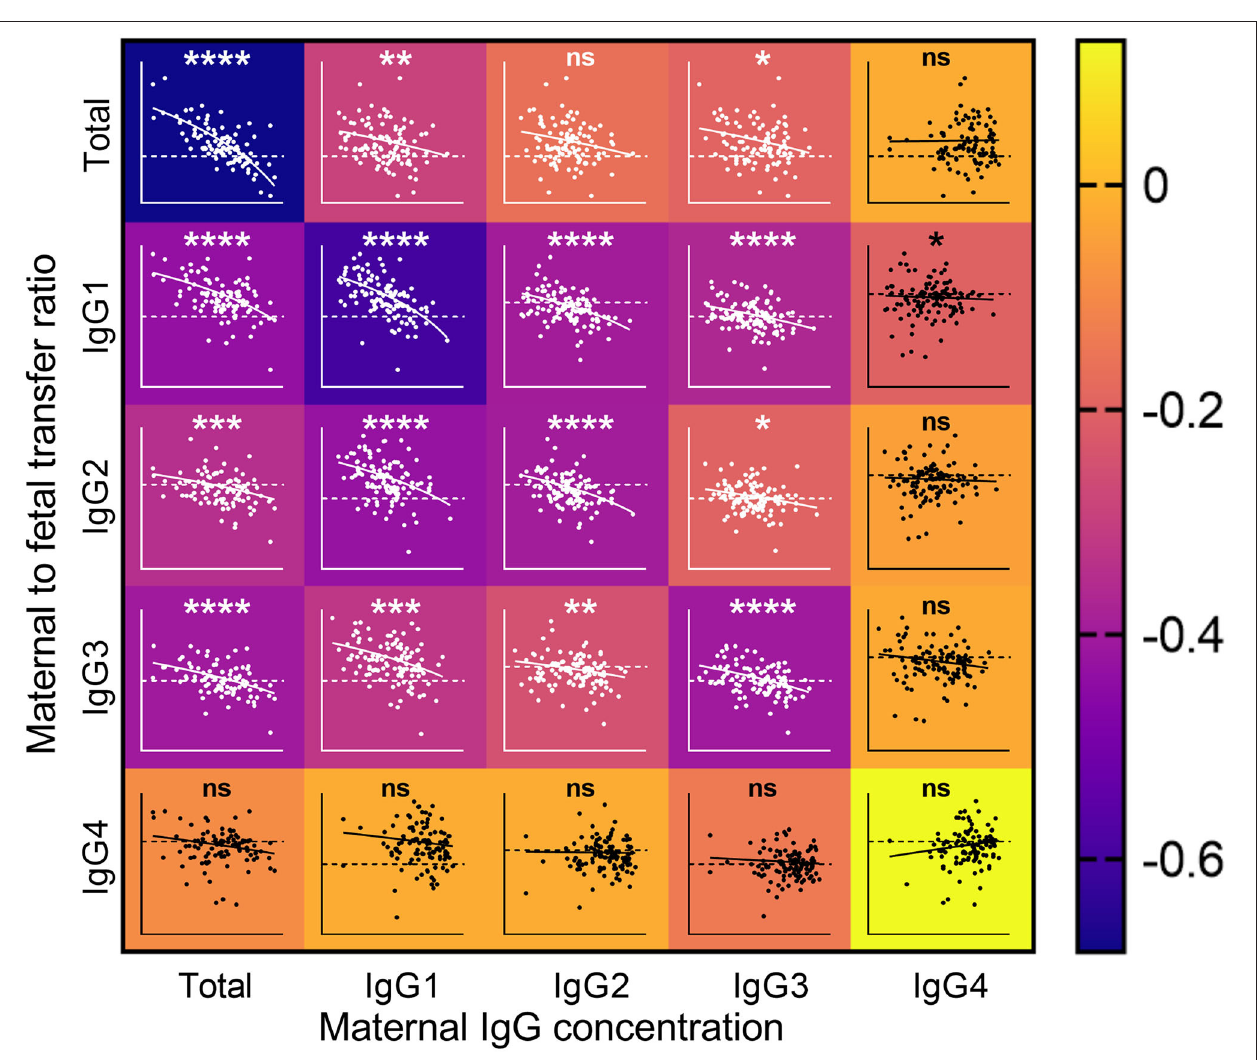
FIGURE 3 | Impact of maternal IgG concentrations on the rate of maternal to fetal IgG transfer. Heatmap with overlaid scatterplots showing the effect of increasing concentrations of maternal IgG ( X axis) on the transfer rates of total IgG (TIgG) and IgG1–4 from mother to fetus ( Y axis, Log2 scale). Horizontal dashed line represents equal levels between mother and fetal circulations. Correlations between nlog-transformed maternal IgG concentrations and log(2)-transformed transfer ratios were analyzed by Spearman’s rank correlation coefficient. The scale on the right indicates the color associated with the Spearman r- values. Inverse correlations are depicted in the darker shades, and weaker and no associations are depicted in lighter shades toward yellow. The lines on the scatterplots indicate simple linear regressions. **** p < 0.0001, *** p < 0.001, ** p < 0.01, and * p < 0.05.